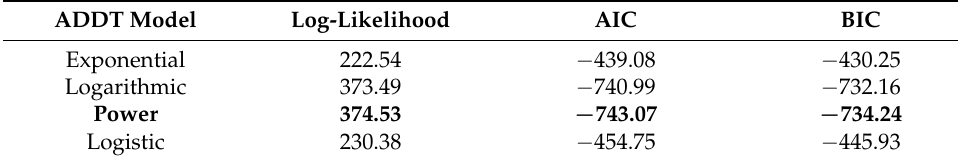
Figure 10. Fitting results of the ADDT data from the four candidate models. Table 2. Stress condition for the failure